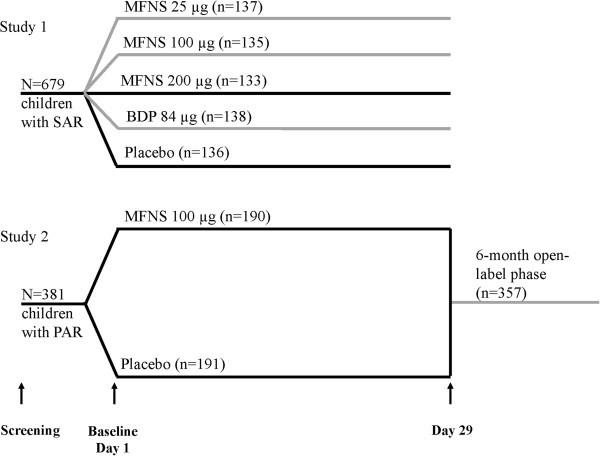
Study designs. BDP, beclomethasone dipropionate; MFNS, mometasone furoate nasal spray; PAR, perennial allergic rhinitis; SAR, seasonal allergic rhinitis. Gray lines indicate study arms or phases not included in this analysis of congestion results.